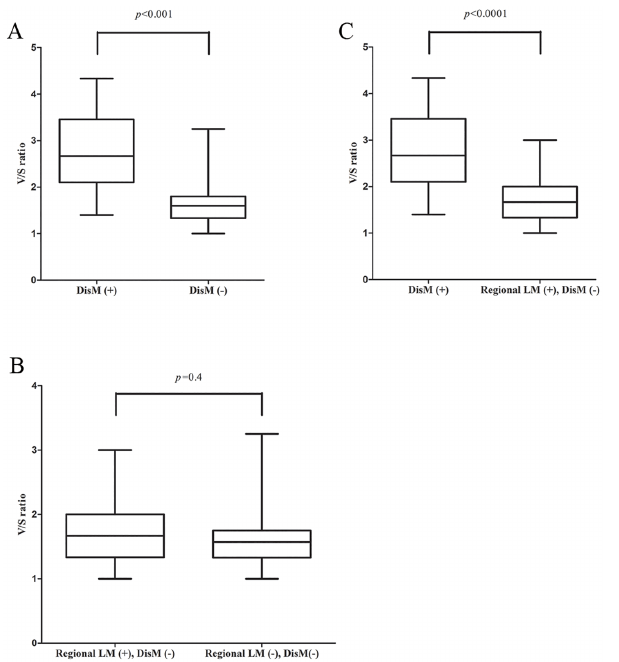
Fig 1. Comparison of averaged visceral fat standardized uptake value/ averaged subcutaneous fat standardized uptake value (V/S) ratio. (A)Between distant metastasis (DisM) and negative DisM. (B) Between regional lymph node metastasis (LM) without DisM and negative regional LM without DisM. (C) Between DisM and regional LM without DisM.